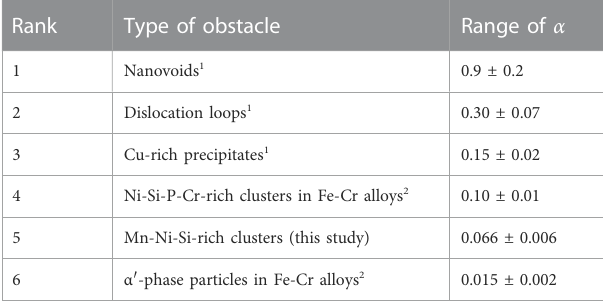
TABLE 4 Ranking of different families of irradiation-induced obstacles with respect to their obstacle strength empirically estimated in the framework of Eq. 2. Values refer to RPV steels and welds if not otherwise stated. The errors were derived from linear